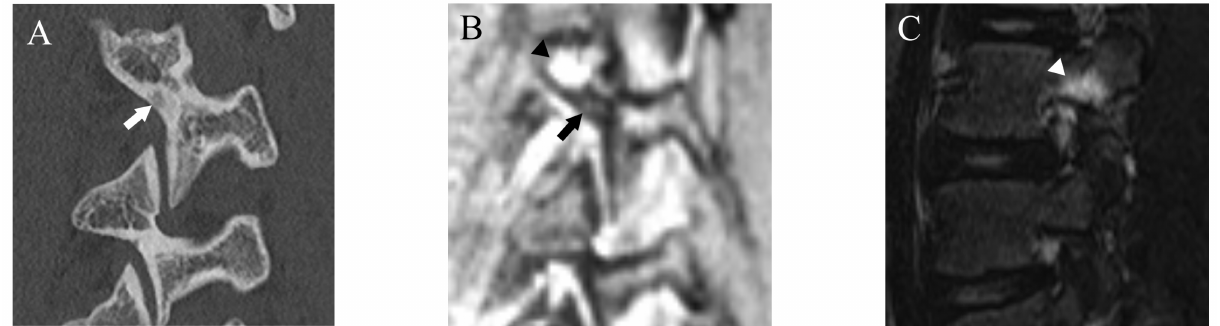
Figure 1. Representative images of grade 1 fracture. The right pars interarticularis of L3 from a 14-year-old male. ( A ) Oblique-sagittal CT image showing faint attenuation in the cortex (arrow). ( B ) The faint attenuation corresponds to slight hyperintensity in the cortex on an oblique-sagittal DESS image (arrow). The window of the image was adjusted to enhance the faint finding. Note the BME in the pedicle (arrowhead). ( C ) Sagittal STIR image shows BME in the right pedicle of L3